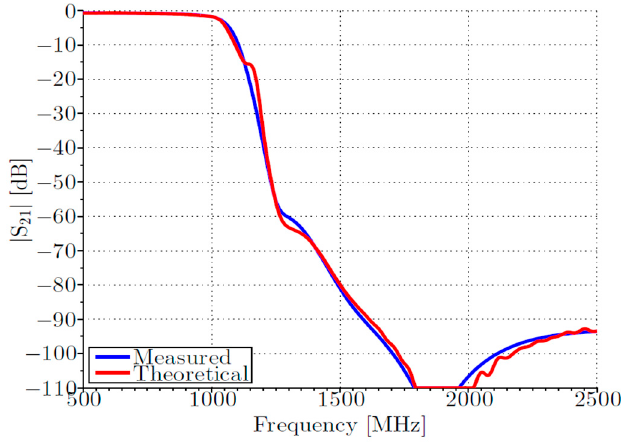
S response when two RBF-272 diplexers in low-pass filter Figure 7. Measured and theoretical Figure 7. Measured and theoretical | S 21 | response when two RBF-272 diplexers in low-pass filter 21 configuration are configuration are cascaded.